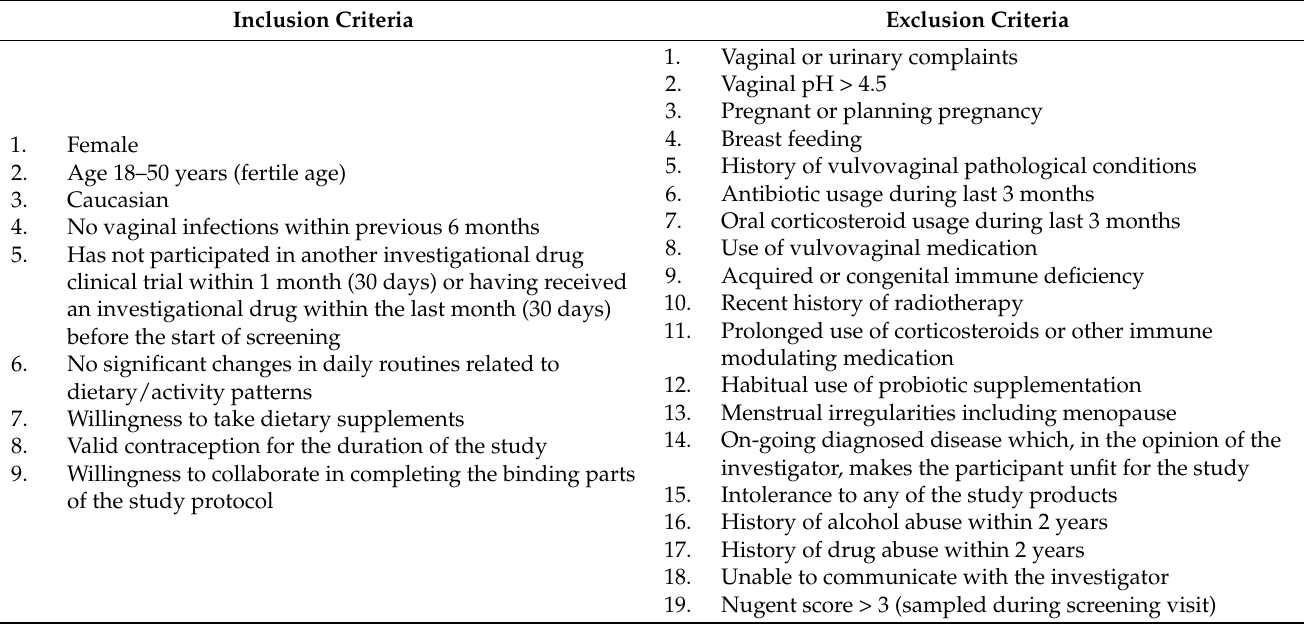
Table 1. Inclusion and exclusion